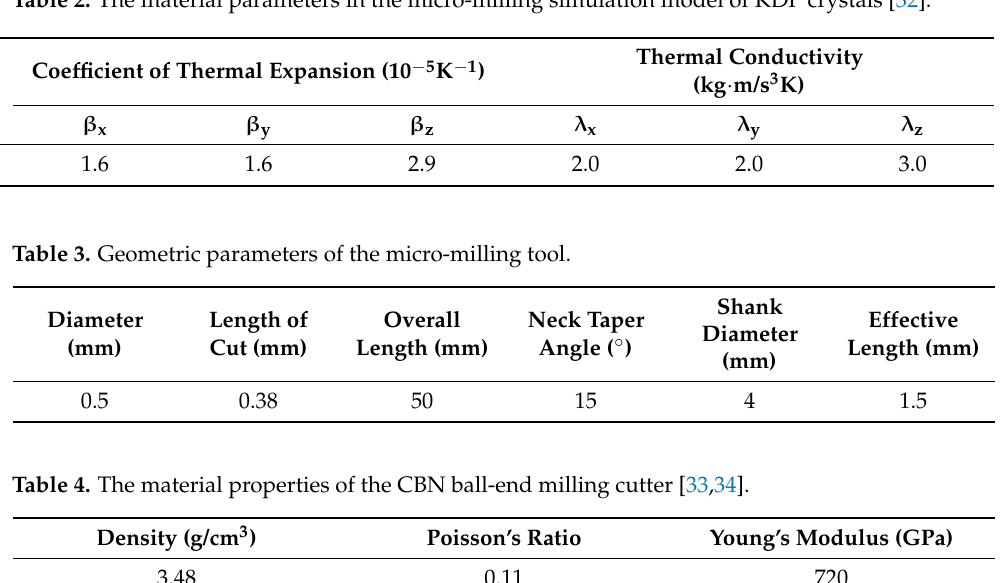
Table 2. The material parameters in the micro-milling simulation model of KDP crystals [32].